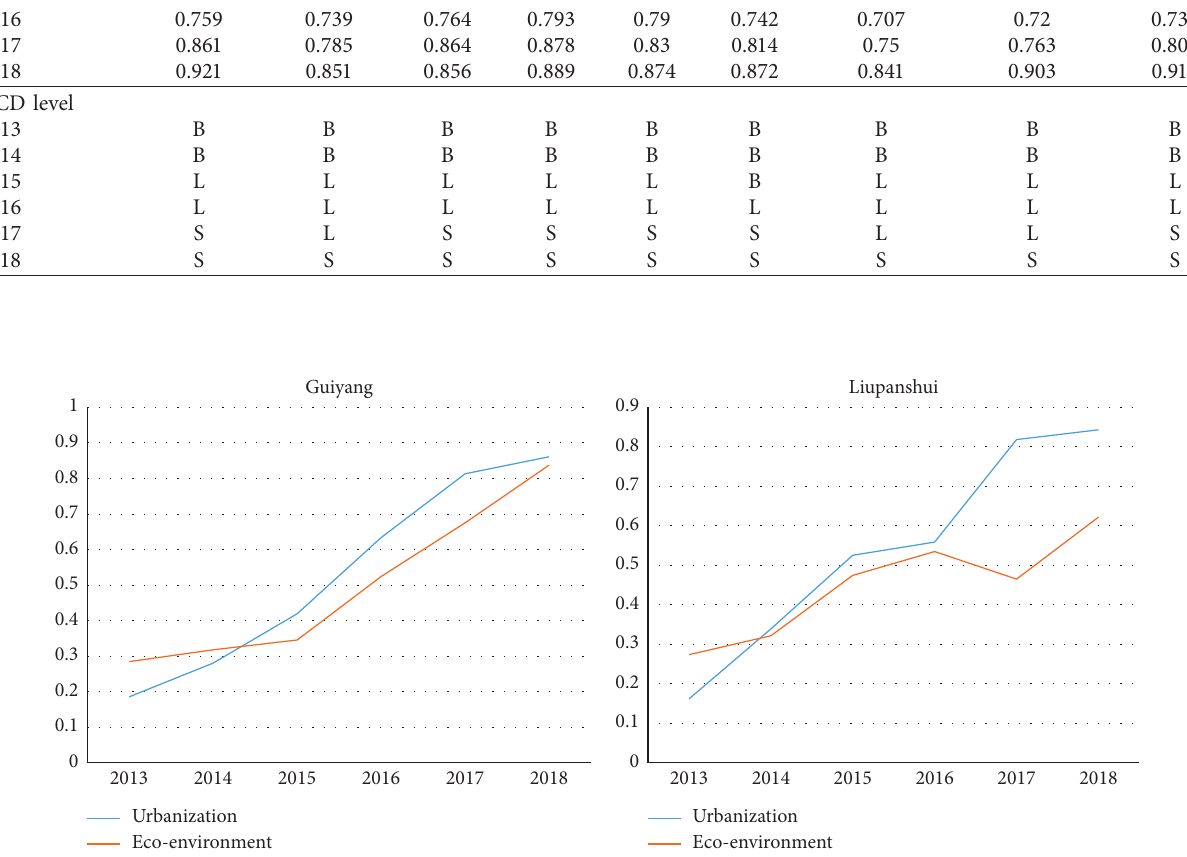
Figure 5: Urbanization and ecological environment levels of Guiyang and Liupanshui in 2013–2018.